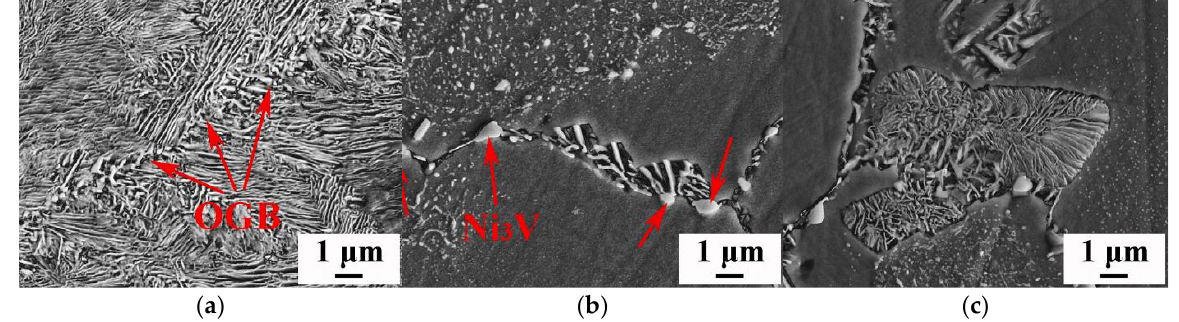
Figure 10. SEM image of discontinuous precipitation at grain boundary of Cu-15Ni-8Sn-xV alloy ( a ) x = 0; ( b ) x = 0.4; ( c ) x = 1.0 [38].